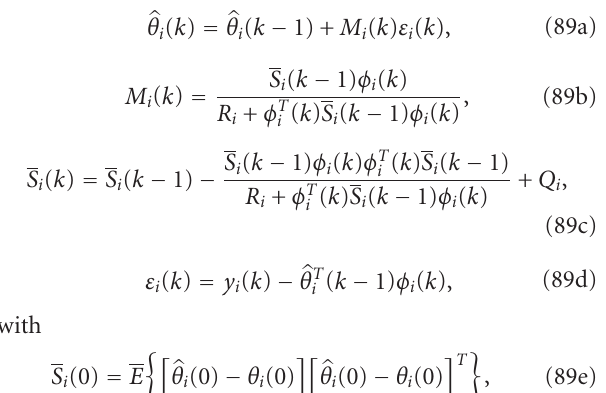
Figure 4: (a) The gradual failure function. (b) The abrupt failure